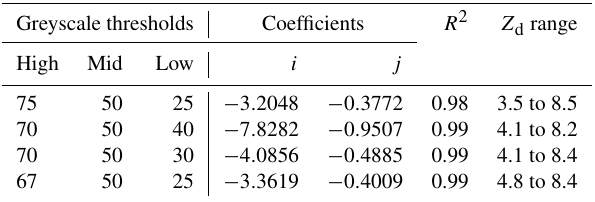
Figure 9. Size distributions of the K07-corrected diameter for drop generator scans of the CIP-15 using the 60µm (a) , 90µm (b) and 120µm (c) printheads. The grey bars show data from all droplets, while the coloured lines show size distributions that have been fil- tered using different Z d thresholds. The Z d of each droplet was determined using Eq. (3). Table 3. Fit coefficients i and j for Eq. (4) for different combina- tions of greyscale